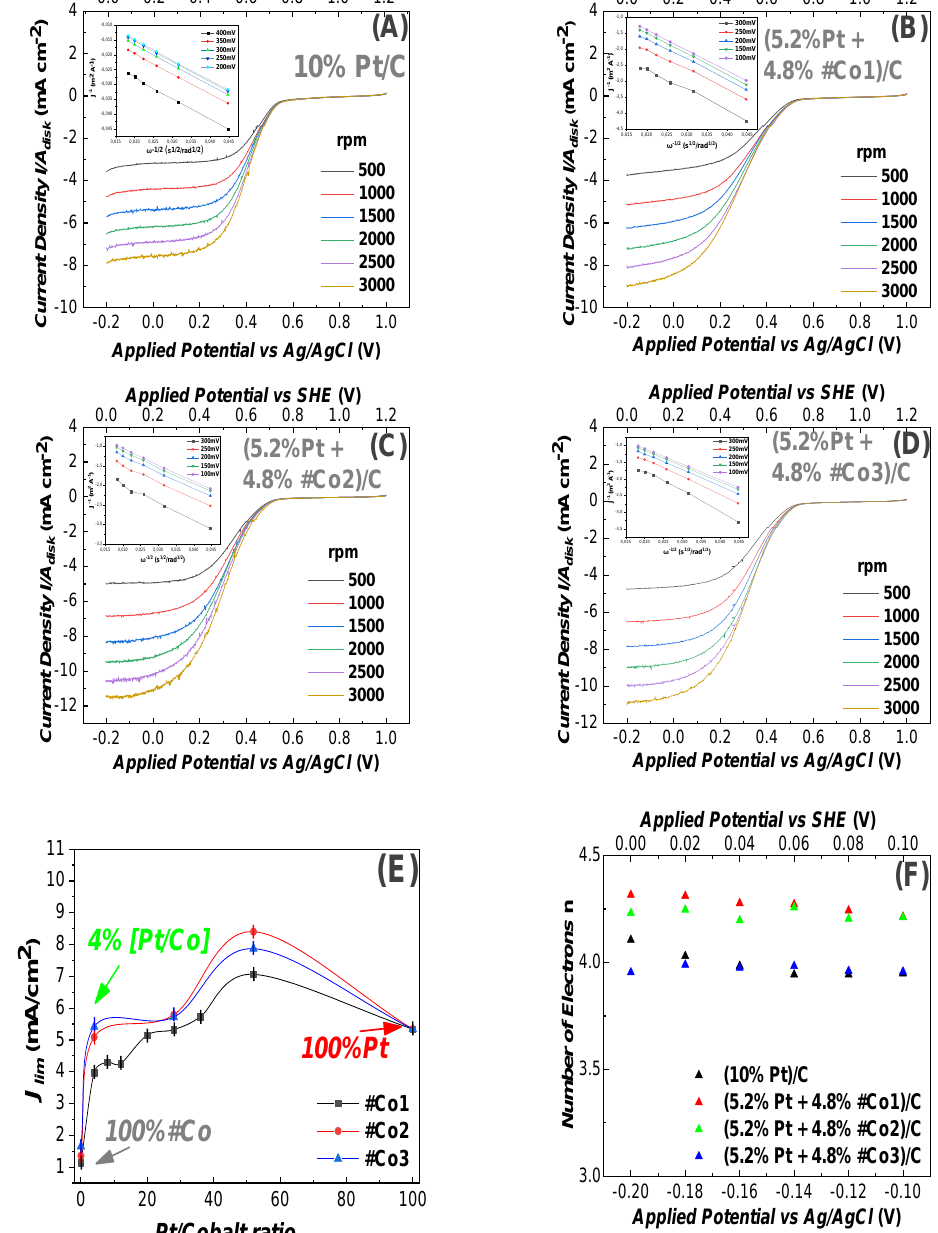
Figure 4. Linear Voltammograms for ORR, recorded using a Glassy-Carbon rotating electrode, loaded with nanocatalysts, in O 2 saturated 0.1 M H 2 SO 4 solution (pH = 1.3). The potential scan rate was 10 mV/s, ( A ) electrode containing 10% Pt/C (reference). In ( B – D ) all electrodes contained (5.2% Pt 4.8% FSP-Cobalt oxide/C). ( B ) #Co1-based electrode, ( C ) #Co2-based electrode, ( D ) #Co3-based electrode, ( E ) Limiting current density versus Pt/Cobalt ratio on the working electrodes, ( F ) Electron transfer number (n), estimated using Equation (6) for the data at 1500 rpm. Insets in A, B, C, D : Elovich plots J lim vs. [rotation frequency] − 1/2